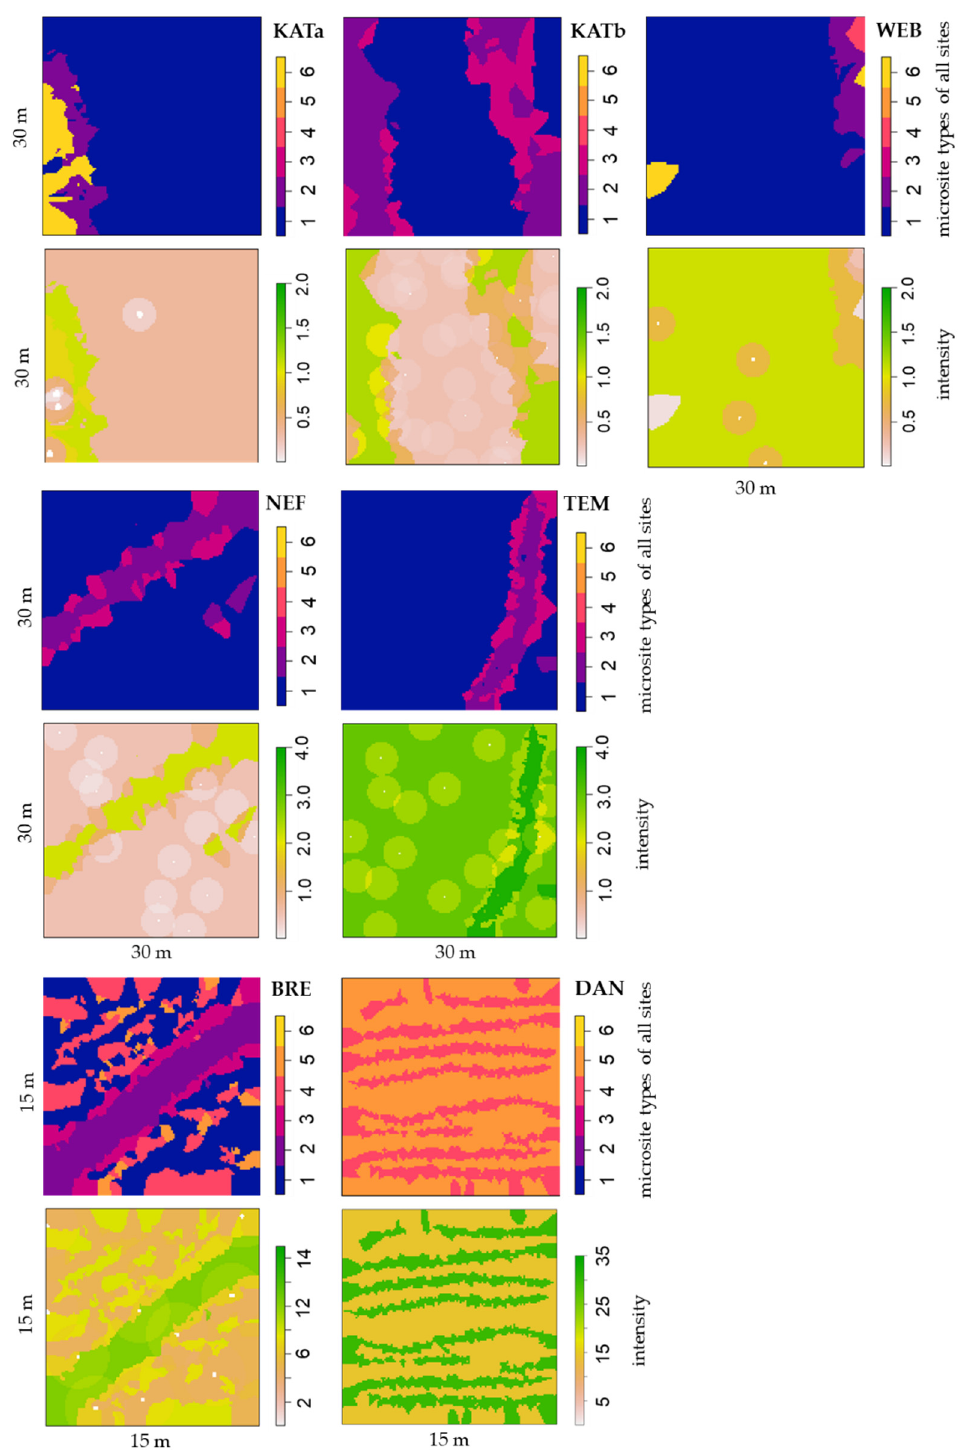
Figure 5. Maps showing the spatial patterns of microsite types on each study site (microsite types: m1—stand without soil scarification, m2—skid trail, m3—skid trail border, m4—hollows or furrows, m5—mounds, m6—stand edge). Visualisation of the results of multitype Strauss hard-core process (MSH) calculations showing the spatial effects of overstorey pine trees and different microsite types on pine seedling densities. Note the different scales of intensities.